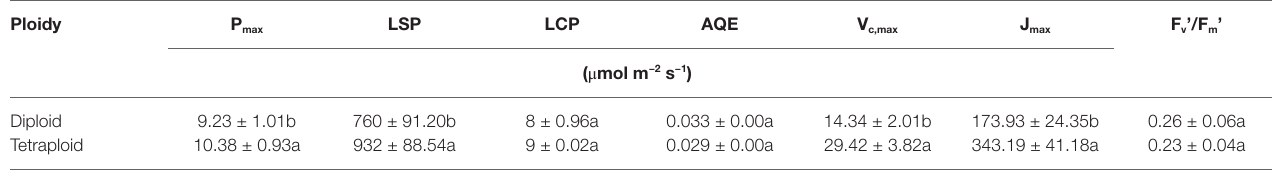
Values represent the mean ± SD (n = 10). Different letters indicate significant differences between the diploid and tetraploid barley leaves in each photosynthetic